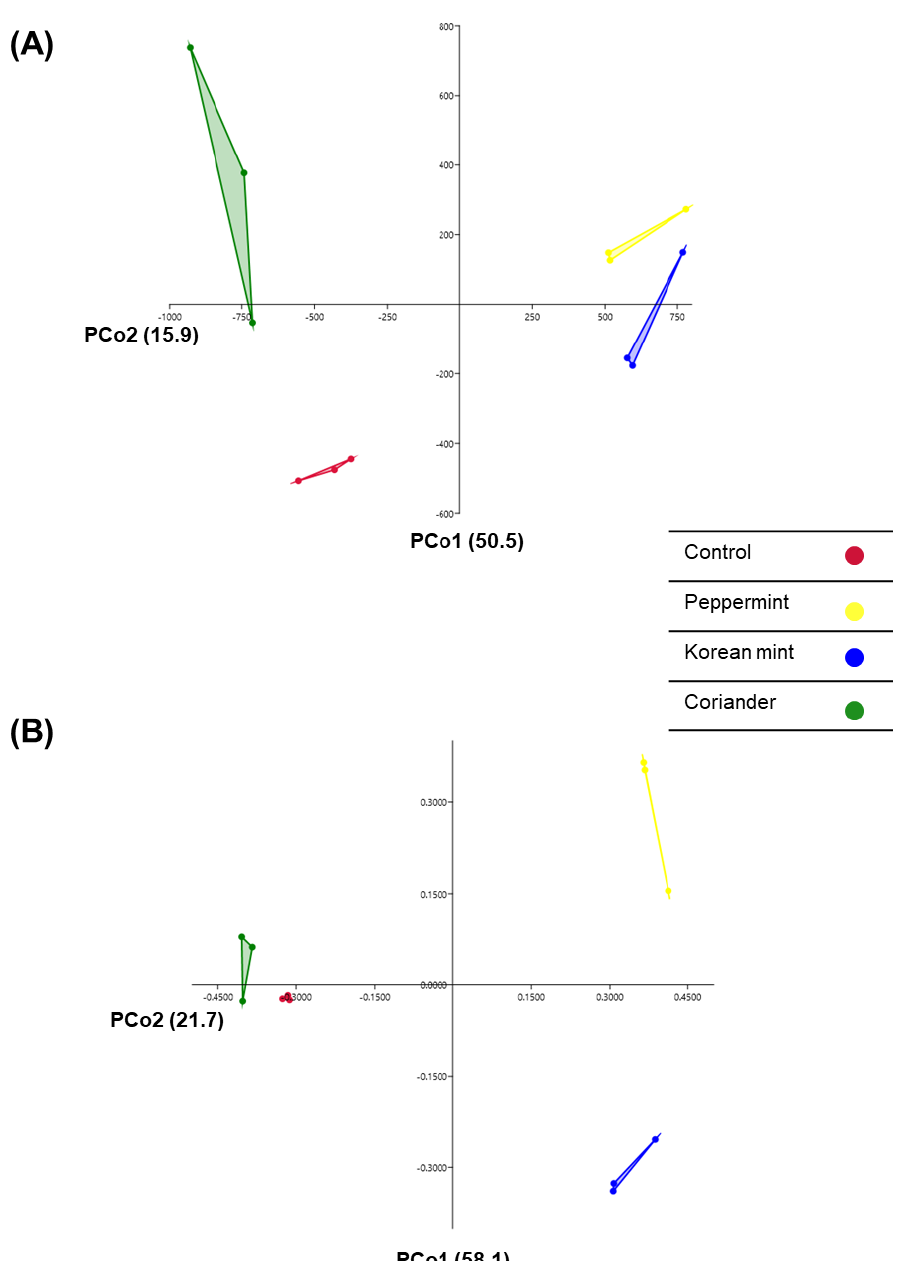
Figure 3. Principal Component Analysis (PCA) of ( A ) Euclidian and ( B ) Bray – Curtis distances of soy paste samples prepared by adding Peppermint, Korean mint, and Coriander, relative to those of the control. Each dot represents a replicate of the different groups of doenjang samples.